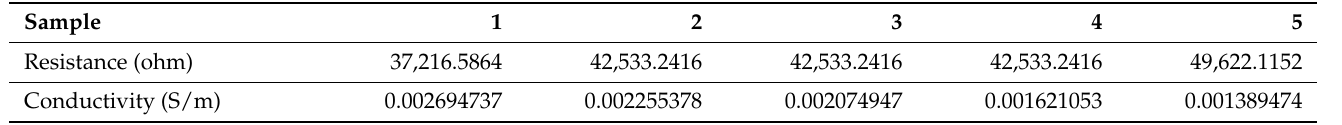
Table A6. Conductivity Data for Nylon 610 Nanocomposites with 0.5 wt% Graphite Nanosheets Treated at 175 ◦ C and − 1